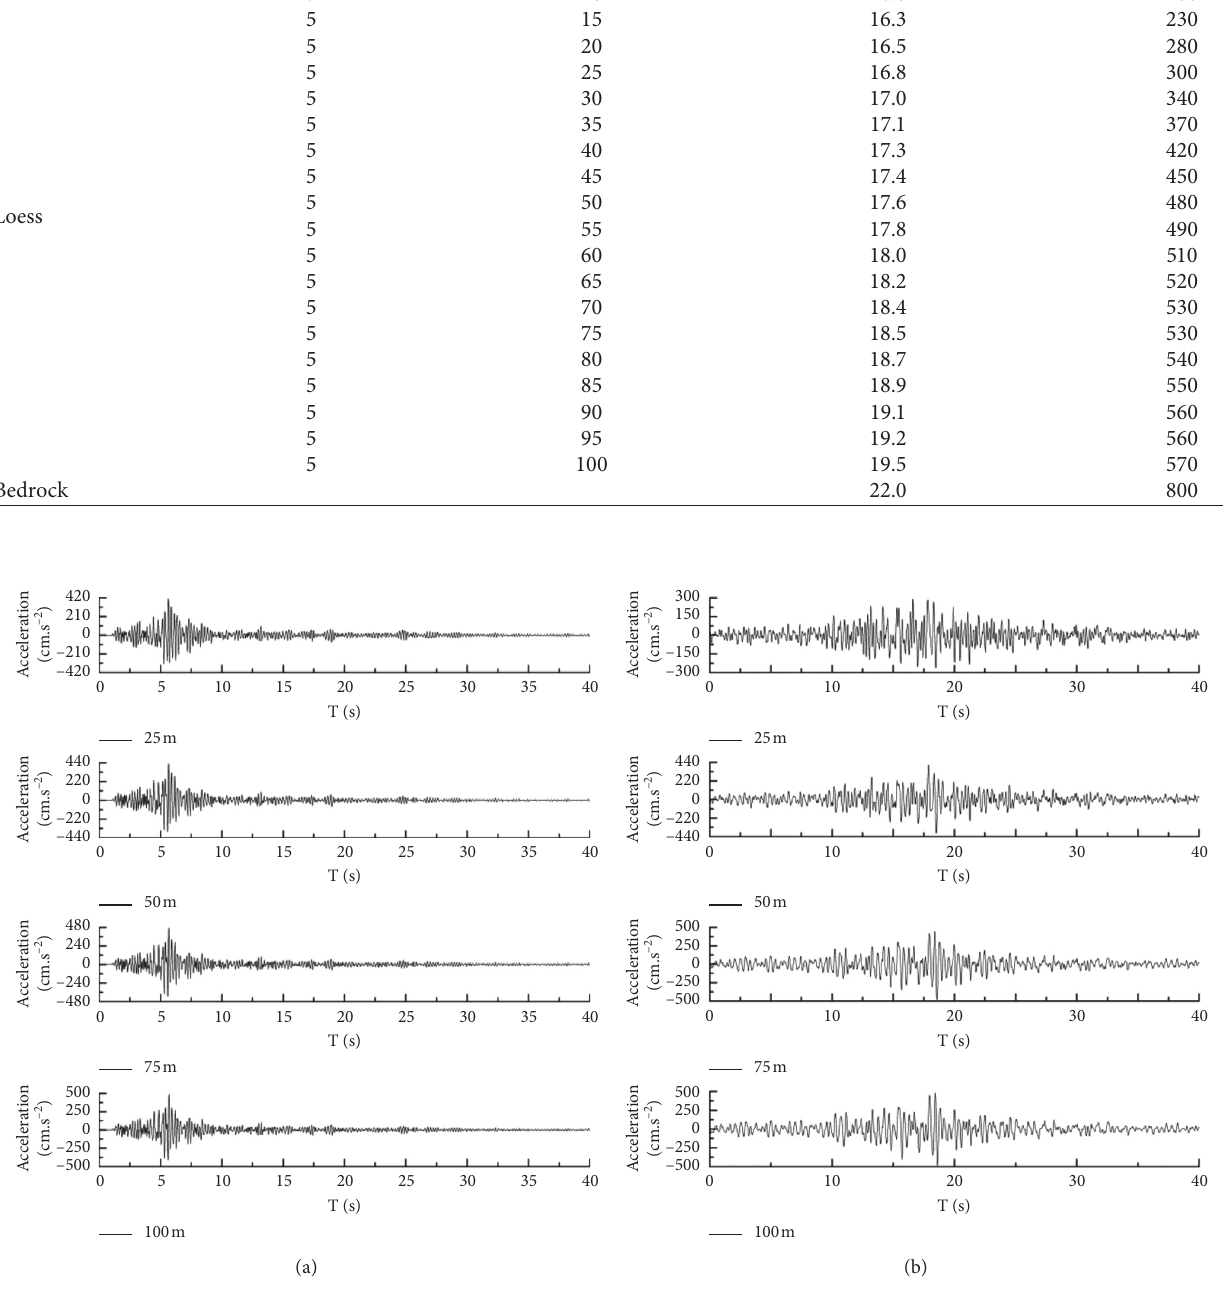
Figure 6: Ground motion acceleration time history of the sites with different overburden thicknesses. (a) Minxian seismic motion. (b) Tianshui seismic